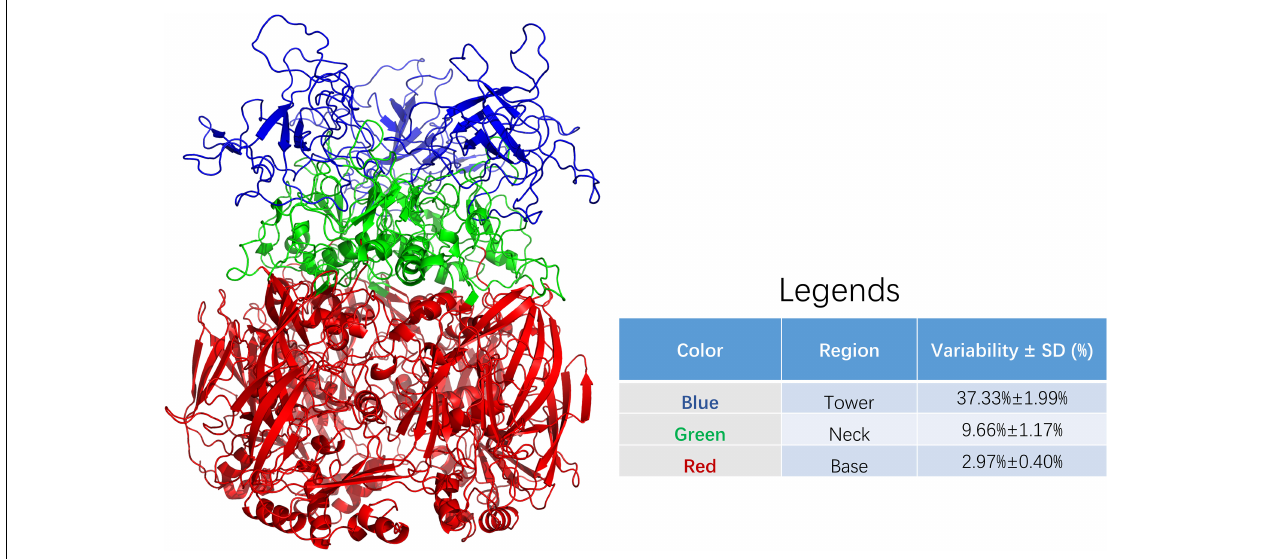
FIGURE 2 | Sequence variability among regions of adenoviral hexon. The adenoviral hexon was divided into three regions including the tower (colored blue), neck (colored green) and bottom (colored red). The variability of each residue based on amino acid sequence alignment from each region was summarized in the legends. The table in legends showed statistically significant differences with F = 331.190 and P <